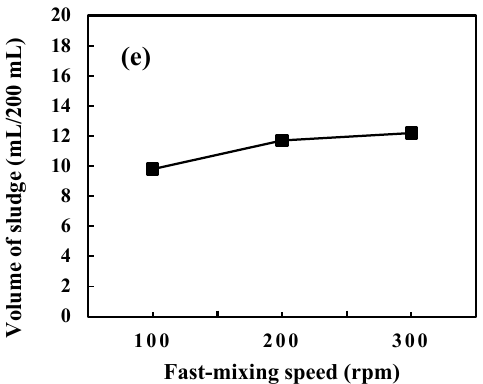
Figure 4. The variations of the produced sludge volume in coagulation-flocculation of As(V) removal related to ( a ) coagulant dosing, ( b ) co-coagulant dosing, ( c ) pH, ( d ) fast mixing time, and ( e ) fast mixing speed parameters.